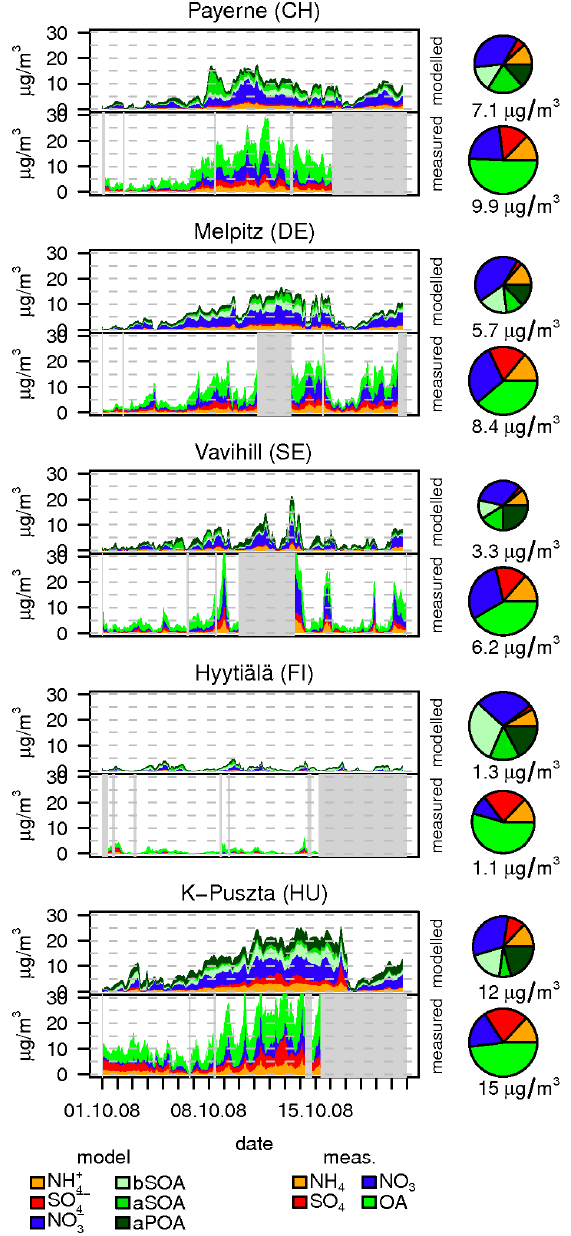
Fig. 9. Timeline of chemical composition of NR − PM 1 (top: modelled, bottom: measured by AMS) during autumn 2008. Pie charts give mean over time period (size of pie relates total mass). Measured OA should be compared with the sum of modelled aPOA, aSOA and bSOA. Gray shaded areas mask times without measurement data.